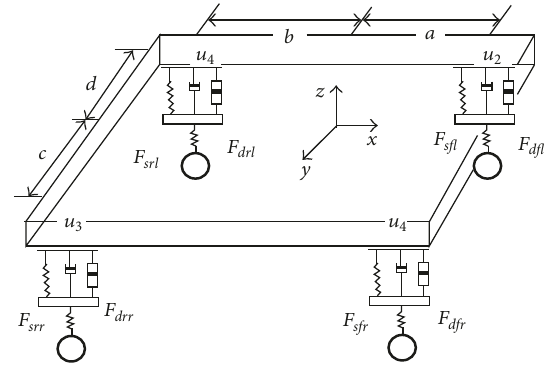
Figure 1: Active suspension structure for the 7-DoF full car